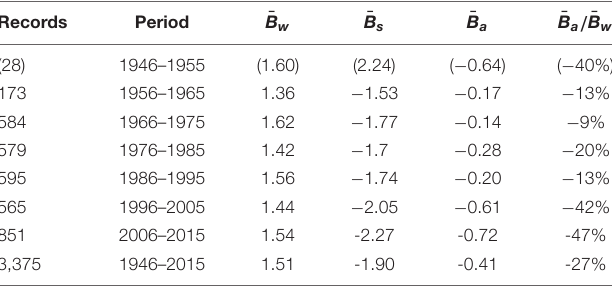
TABLE 2 | Inter-decadal variations in available data for winter, summer, and annual balances.